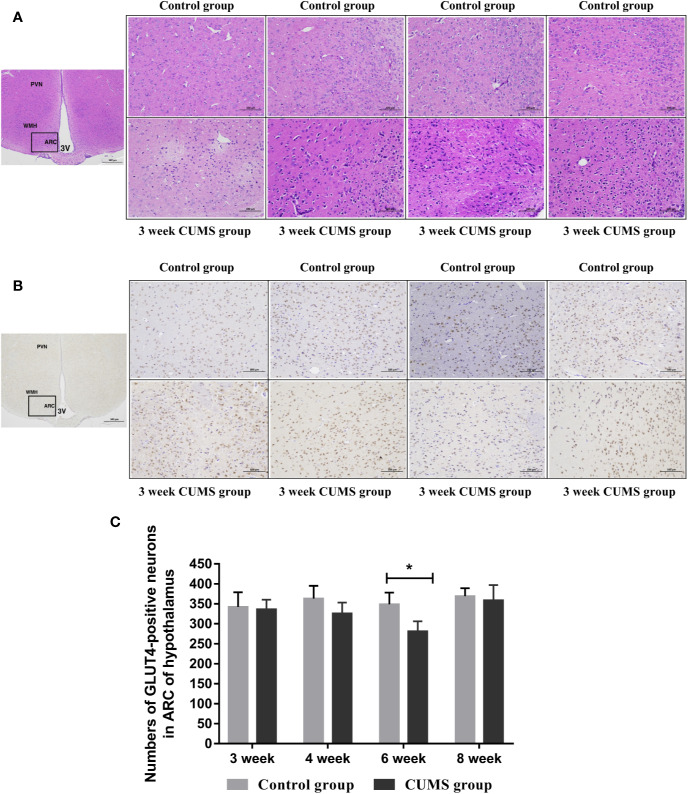
The influence of CUMS on histomorphology and GLUT4-postive neurons in hypothalamus of rats. (A) Representative micrographs of neurons in hypothalamus. (B) Representative micrographs of immunohistochemical staining for the GLUT4 proteins in the hypothalamus. The first micrographs was captured at low magnification (scale bar = 500 μm, 40x magnification); the remaining micrographs were captured at higher magnification (scale bar = 100 μm, 200x magnification), and observed the ARC of hypothalamus. (C) Quantitative analysis of the numbers of GLUT4-poistive neurons in the ARC of hypothalamus. PVN, paraventricular nucleus; VMH, ventromedialnucleus; ARC, arcuate nucleus; 3V, third ventricle. Data are presented as mean ± SD, n = 4 in immunohistochemical analysis; *p < 0.05 vs. Control group.